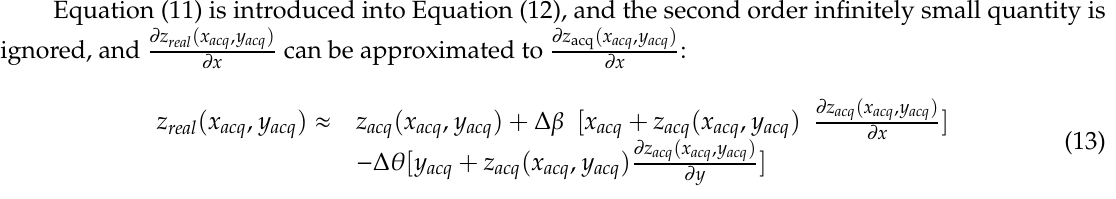
Figure 7. The outline of the sample measured by stylus profiler.